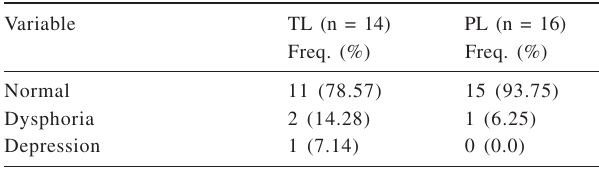
Table 4 - Results of the questionnaire Beck Depression Inventory.